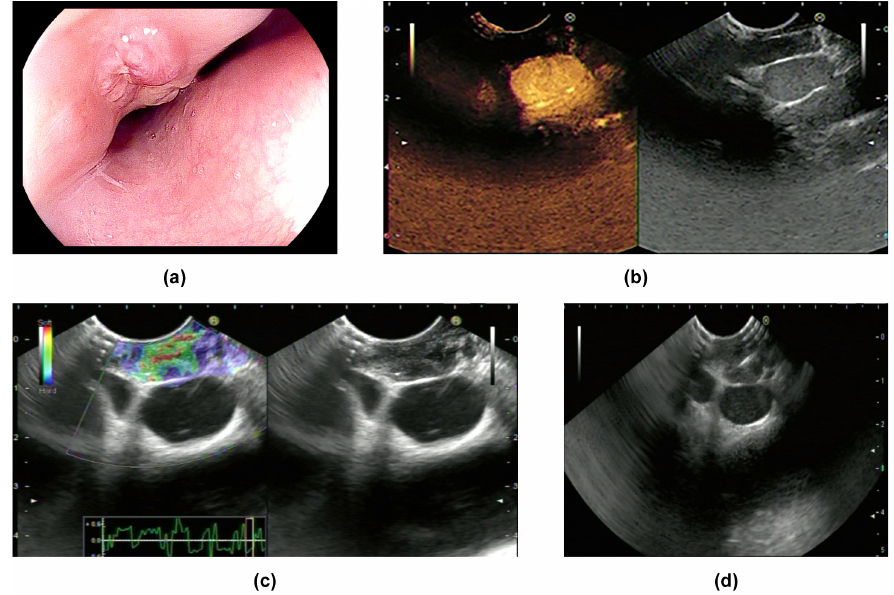
Figure 1. Manifestations of Case 1: ( a ) manifestations of the lesion according to EGD; ( b ) the lesion was hypo-enhanced according to CH-EUS; ( c ) the lesion was soft according to elastography; ( d ) EUS-FNA for the lesion.